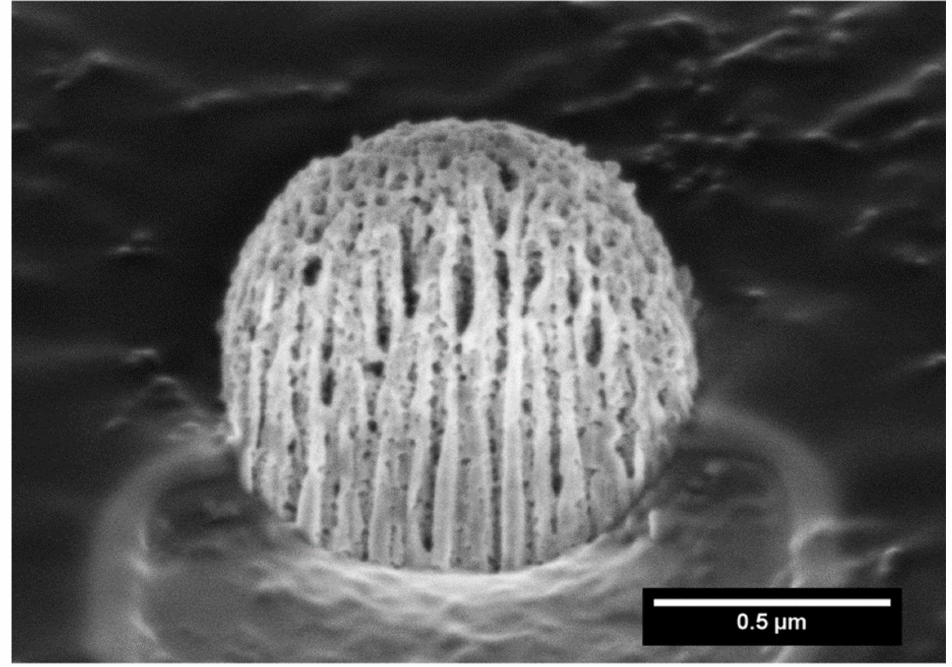
Figure 2. Focused ion beam scanning electron microscopy (FIB-SEM) of a MIL-100 capsule